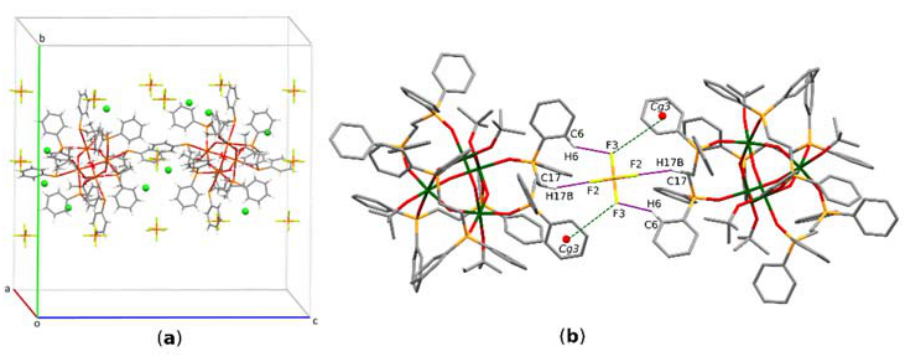
Figure 3. ( a ) Partial molecular packing of I ; ( b ) C-H ... F and F ... π interactions in I . Green spheres